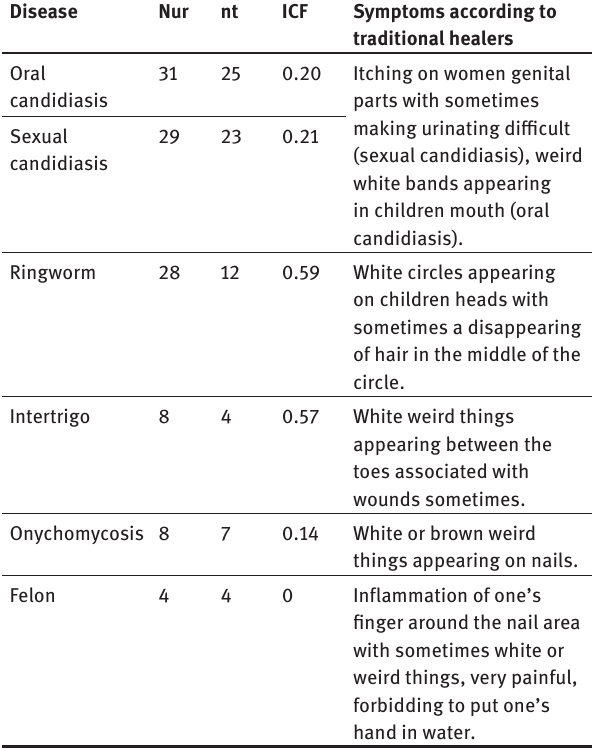
Table 4: The main Symptoms of the fungal diseases and the Informant Consensus Factor